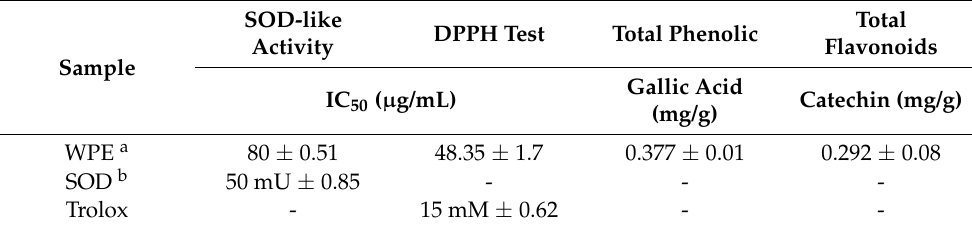
Table 4. Antioxidant activity and total phenolic and flavonoid contents of walnut pellicle extract.